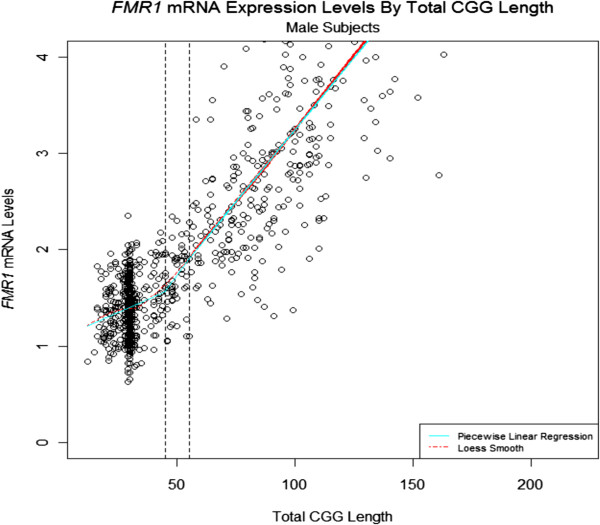
Quantification of FMR1 mRNA levels in the three allele categories (normal, intermediate, and premutation) shows that FMR1 mRNA expression increases significantly with increasing CGG repeat number. The solid blue line on the plot shows a piecewise linear regression fit, with FMR1 mRNA expression increased significantly in all three groups (P = 0.012, P < 0.001, and P < 0.001 for normal, intermediate, and premutation carriers, respectively).